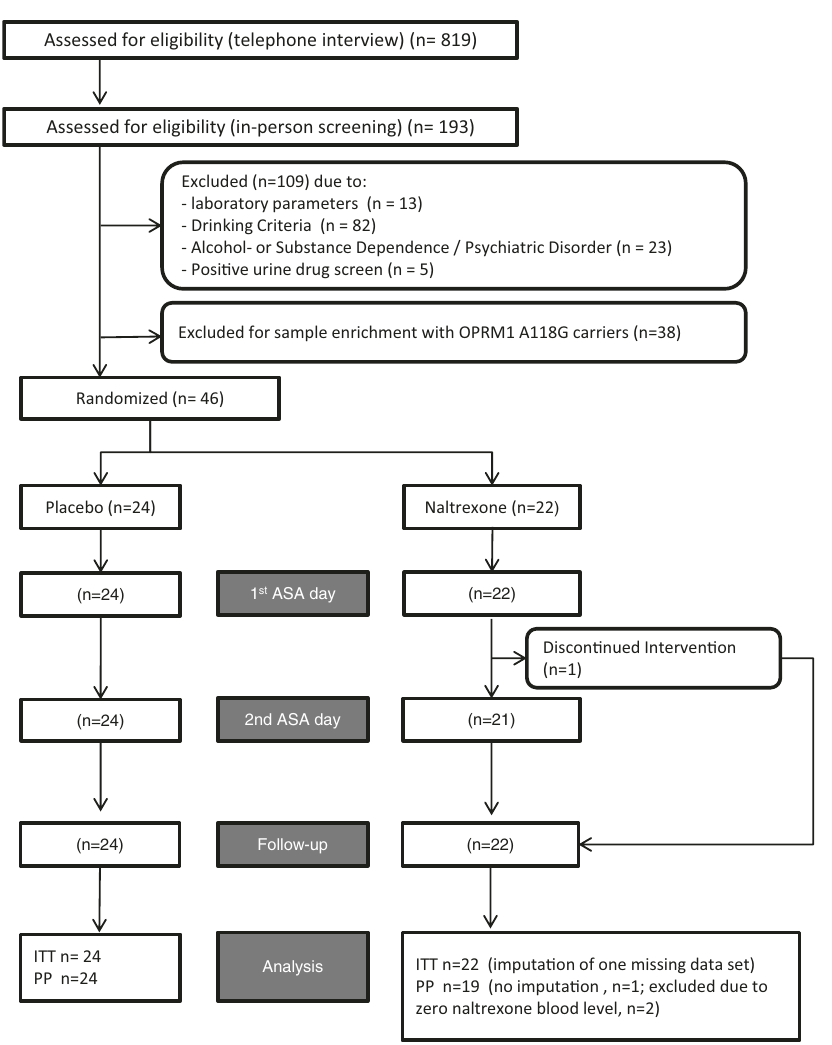
Fig. 1 Recruitment and retention fl owchart. CONSORT fl owchart of recruitment and retention throughout the study. ITT intention-to treat, PP